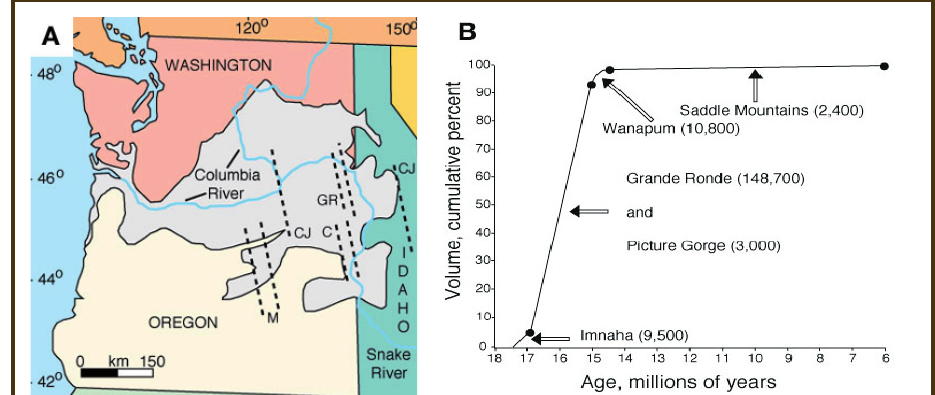
Figure 7. [A] Map of the Columbia Plateau, showing the limits of the Columbia River flood basalts and the feeder dike systems (dashed lines). CJ indicates the longitudinal boundaries of the Chief Joseph dike swarms that fed the Clarkston (Imnaha, Grande Ronde, and Wanapum) and Saddle Mountain basalts. The Grande Ronde (GR) and Cornucopia (C) swarms are concentrations within the CJ. M indicates the Monument dike swarm that fed the Picture Gorge basalt. [B] Ages and estimated volumes of the major eruptive units of the Columbia River basalts. This figure illustrates that surficial sampling of a LIP can yield information on its history of